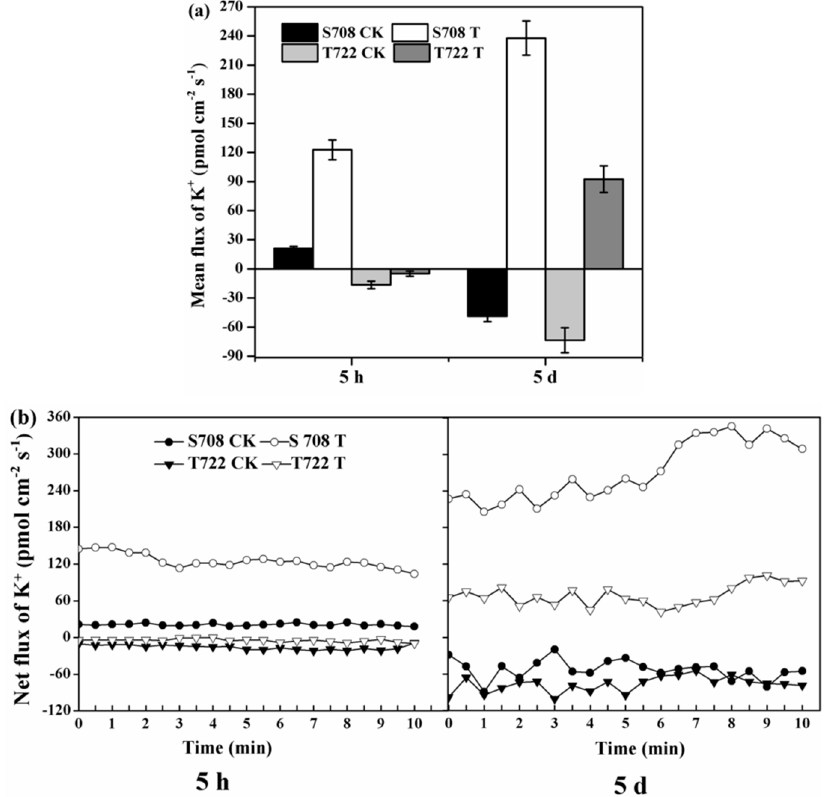
Figure 4. Net flux of K + in root tips of S708 and T722 cultivars under normal (CK, 25 / 18 ◦ C) and sub-optimal temperature (T, 15 / 10 ◦ C) conditions. After being treated with normal and sub-optimal temperatures for 5 hours and 5 days, a continuous flux recording of 10 min was conducted. ( a ) Mean fluxes of K + and ( b ) net flux of K + in both cultivars within the measuring periods. The data were collected every 6 s during the 10 min measuring period. The positive values in the figures represent K + efflux and negative values represent K + influx.